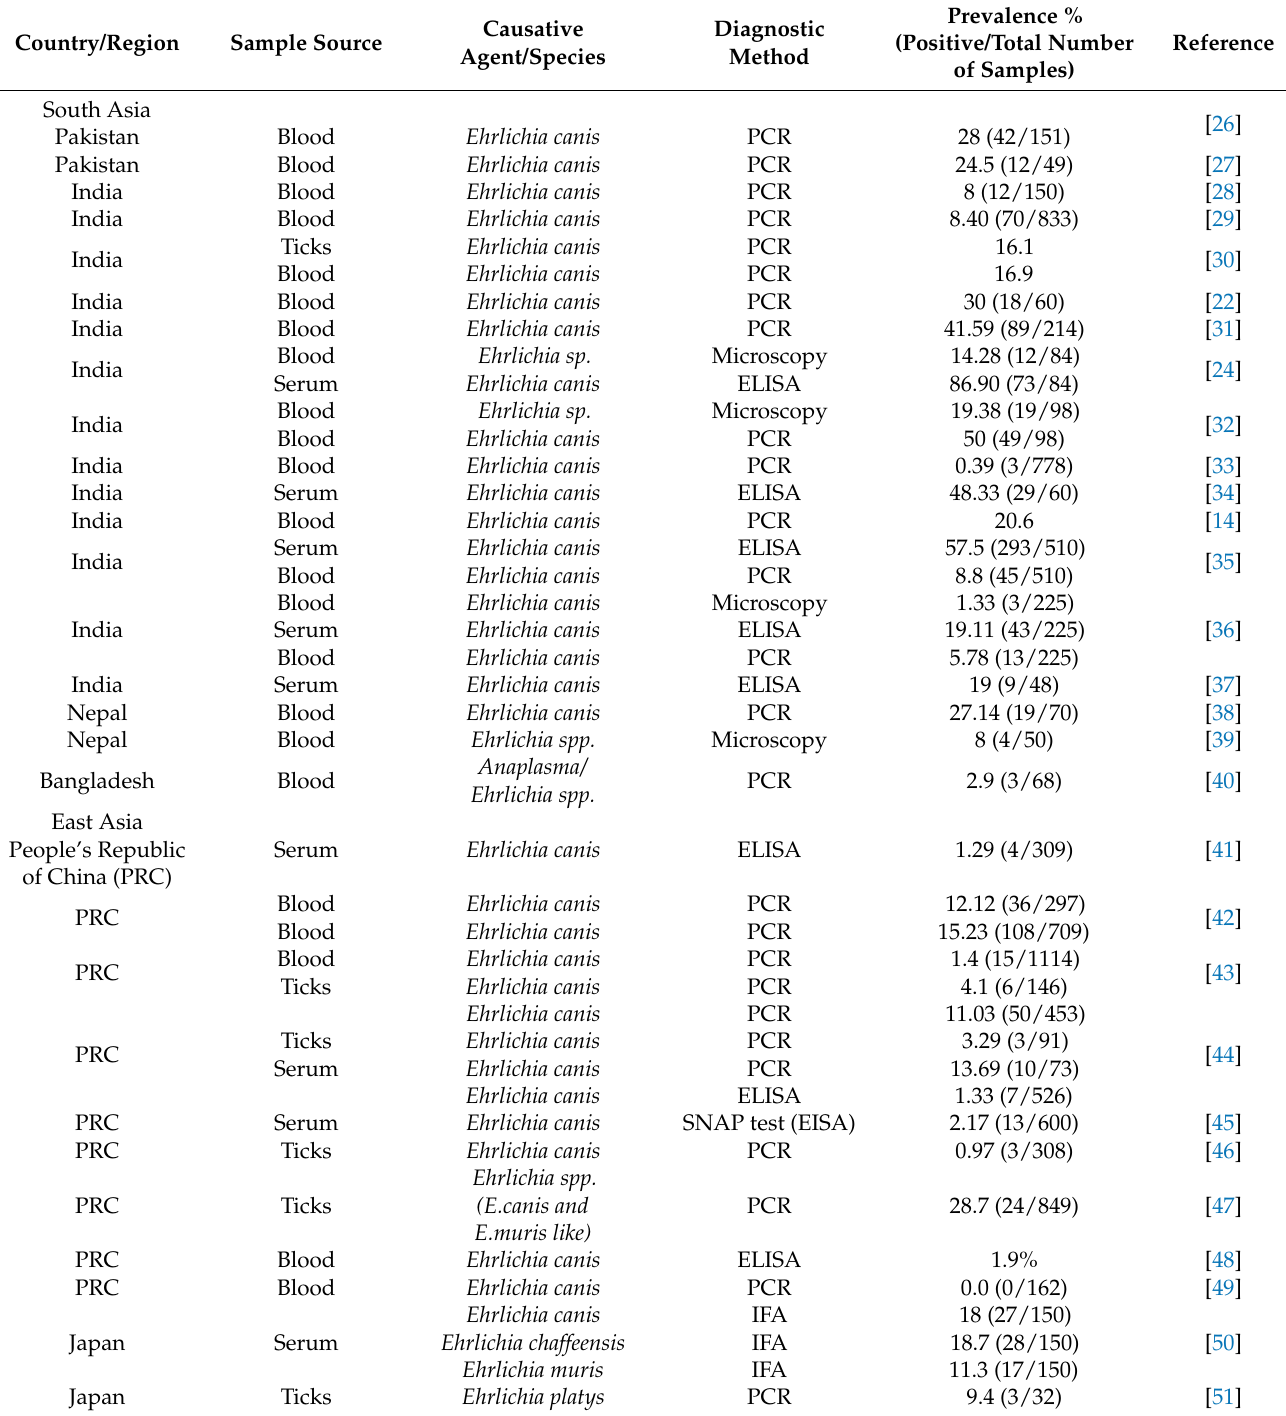
Table 1. Prevalence studies on ehrlichiosis in dogs conducted in south and east Asian